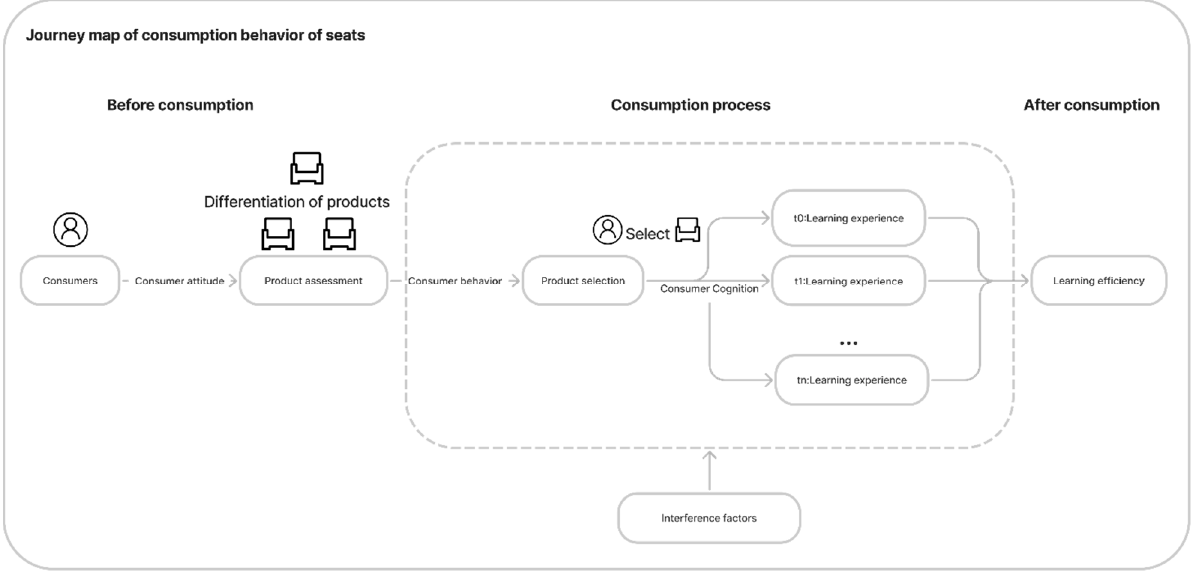
Figure 4. Journey map of consumption behavior of seats.